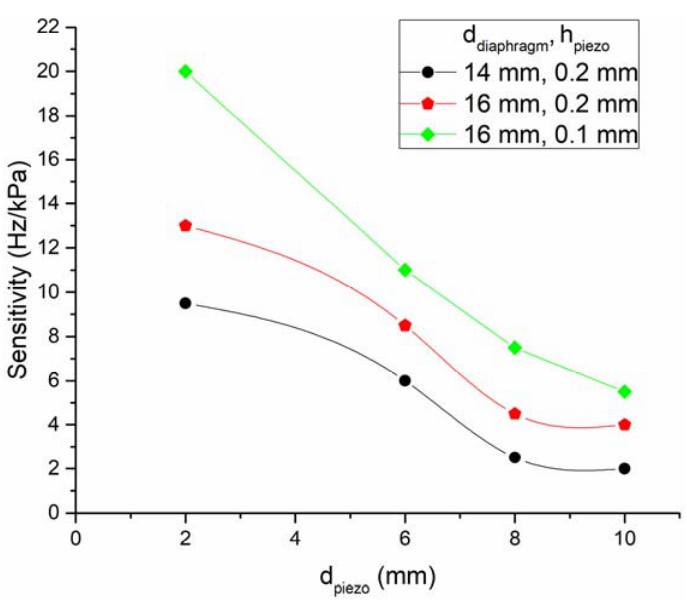
Figure A1. Pressure sensitivity as a function of diameter of the piezoelectric disc (d piezo ) with variation of other characteristic dimensions, i.e., diameter of the diaphragm (d diaphragm ) and thickness of the piezoelectric (h piezo ).